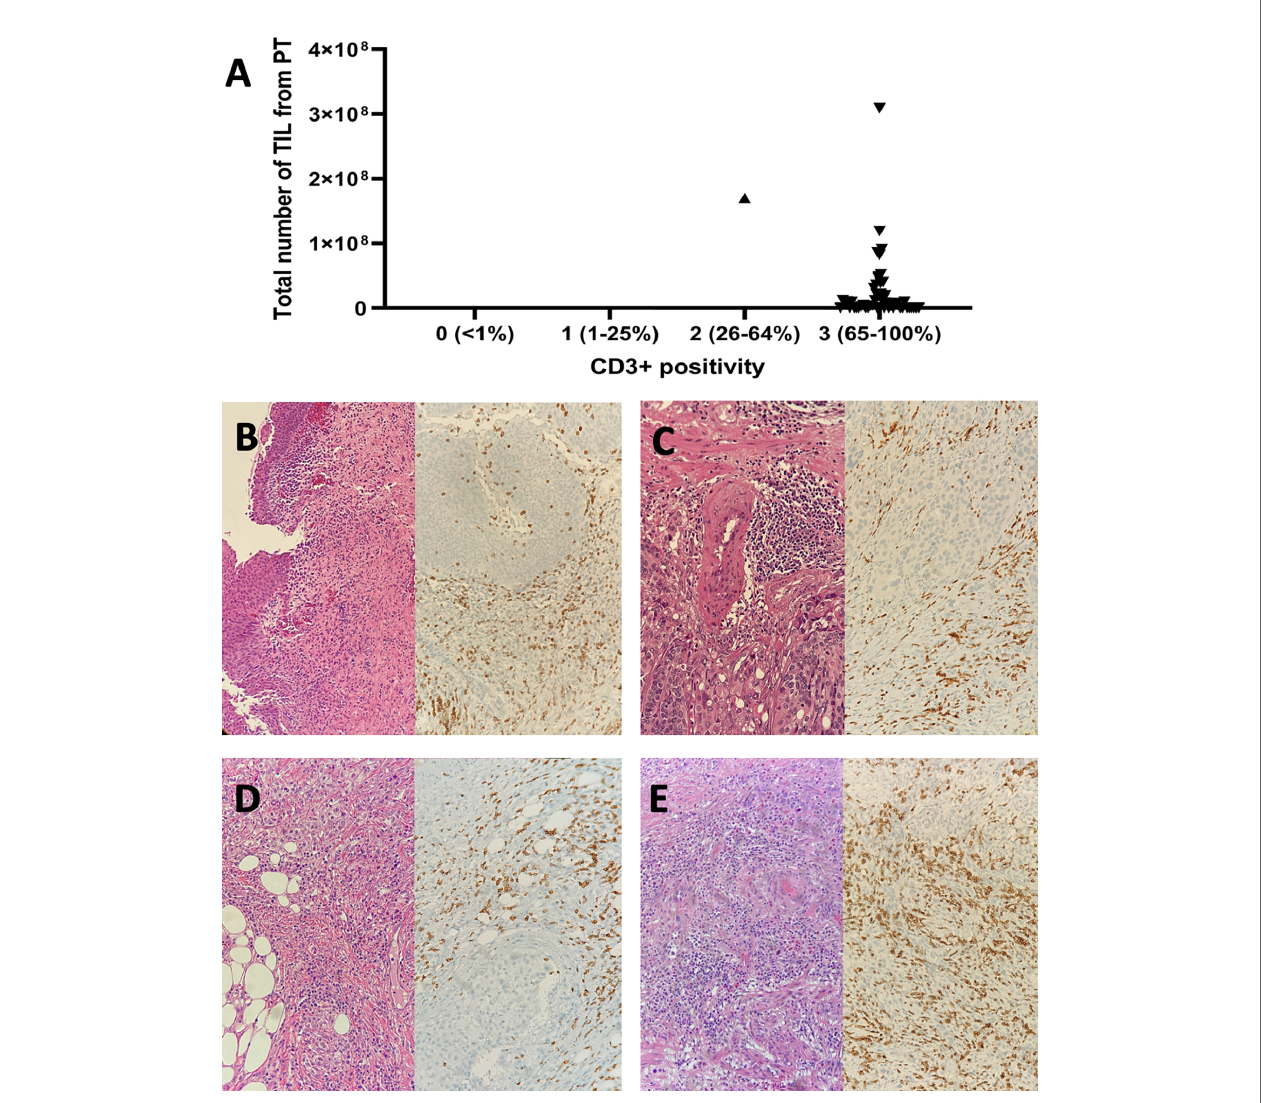
FIGURE 3 | The CD3+ tumor in fi ltrating lymphocyte in fi ltration within tumor microenvironment and expansion of TIL from primary bladder tumors. (A) Expansion of TIL was achieved in 33 out of 51 primary tumors, of which 50 and one displayed strong and moderate CD3+ T cell in fi ltration, respectively. (B) A pTis bladder tumor (pure urothelial call carcinoma) previously treated with BCG immunotherapy (Left: H-E x 100; Right: Anti-CD3 Ab x 200). (C) A pT2 bladder tumor (pure urothelial cell carcinoma) previously treated with BCG immunotherapy (Left: H-E x 200; Right: Anti-CD3 Ab x 200). (D) A pT3 bladder tumor (pure urothelial carcinoma) with no previous exposure to intravesical BCG (Left: H-E x 200; Right: Anti-CD3 Ab x 200). (E) A pT2 bladder tumor (squamous differentiation) with no previous exposure to intravesical BCG (Left: H-E x 200; Right: Anti-CD3 Ab x 200). H-E, hematoxylin and eosin; Ab, antibody; pT, pathological tumor